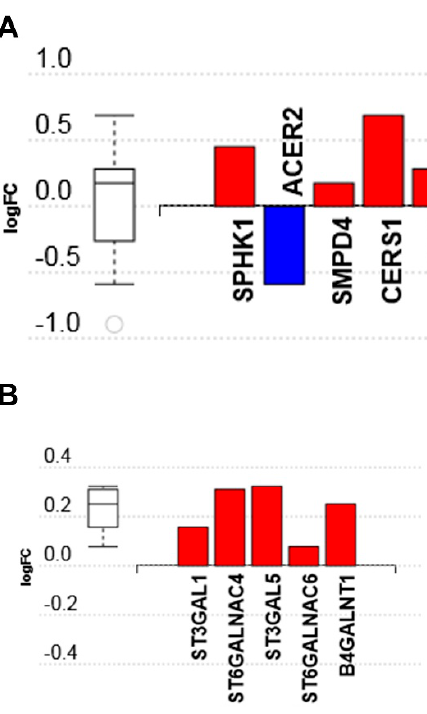
Figure 3. The sphingolipid metabolism mRNA transcripts regulated in response to C16 ceramide-enriched LDL in human podocytes. Podocytes were induced with 200 µg/mL C 16 ceramide-enriched or native LDL and incubated for 7 h at 37 °C, 5% CO2; RNA was extracted and RNA-seq assay was performed as described under Methods. ( A ) Sphingolipid metabolism; ( B ) glycosphingolipids synthesis. Figure generated using iPathwayGuide (Advaita Bioinformatics) software; log FC, logarithm of fold change of gene expression. Box and whisker plot: The ends of the box are the upper and lower quartiles, box spans the interquartile range. Horizontal line inside the box denotes the median and the whiskers are the two lines outside the box extend to the highest and lowest observations.